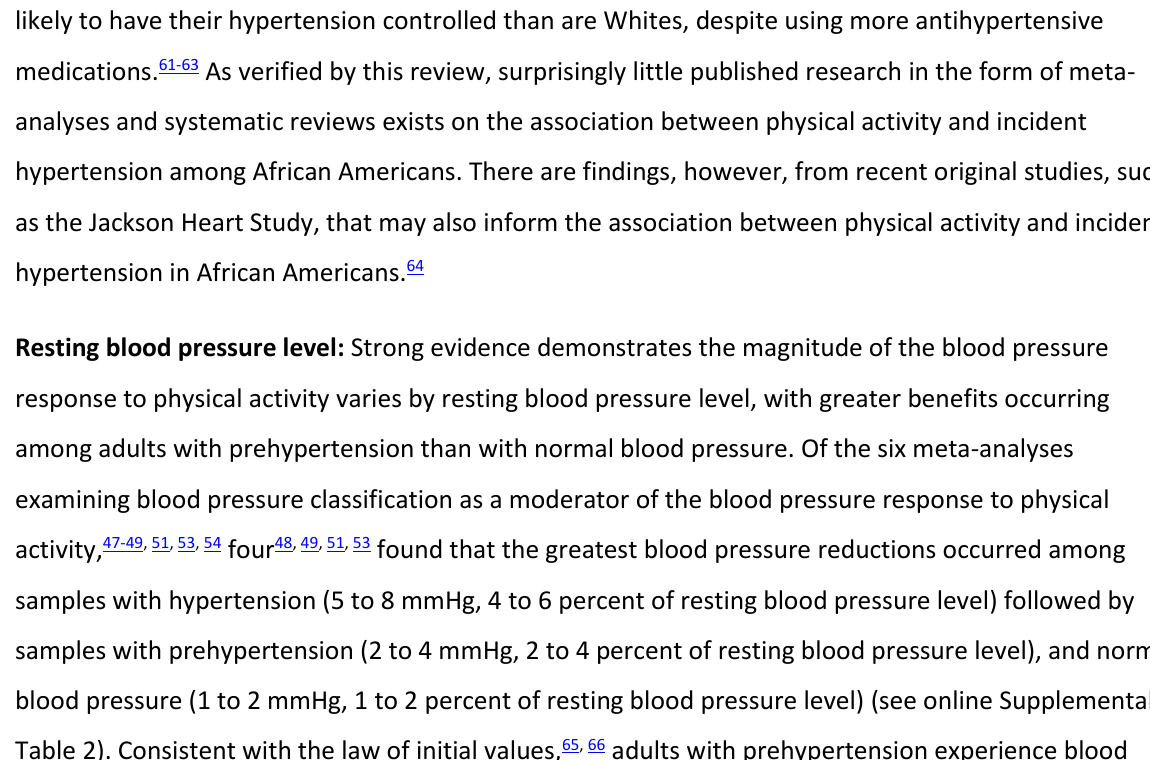
Table 2). Consistent with the law of initial values, 65, 66 adults with prehypertension experience